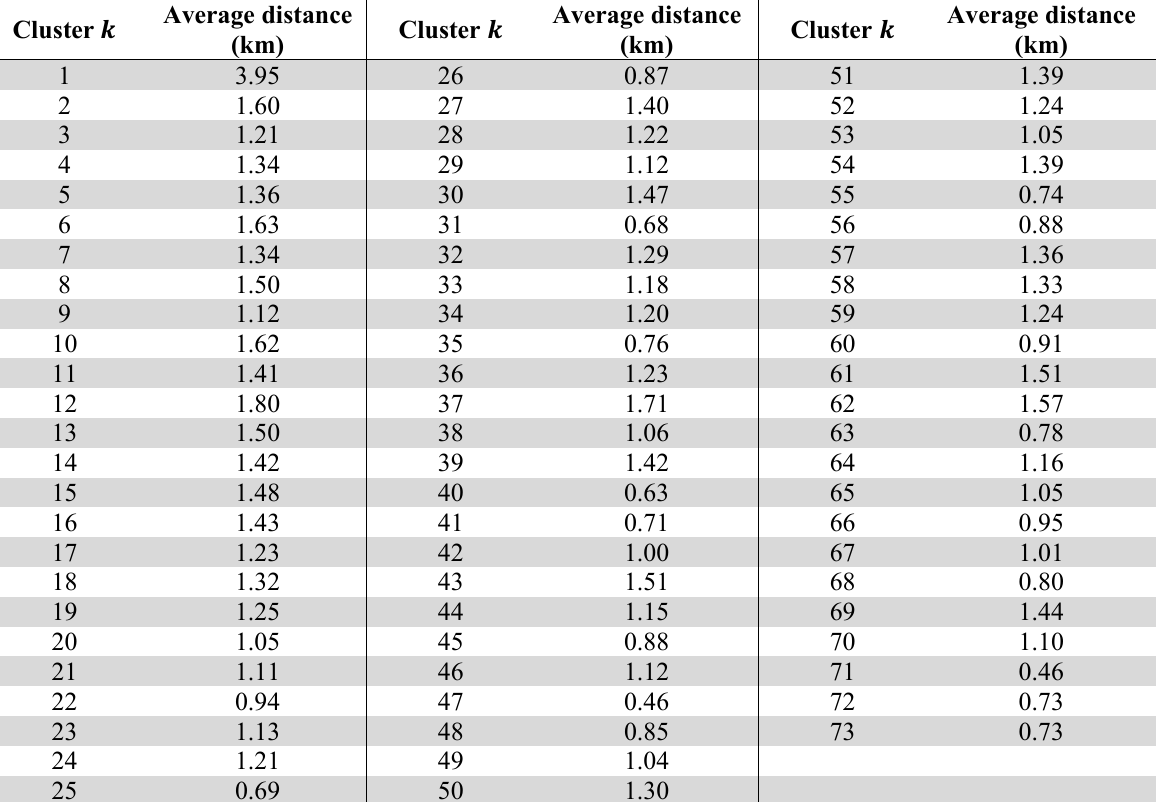
Fig. 6. Example of geographical distribution of ten clusters generated with a) centroid-based algorithm, and b) sweep algorithm Results of centroid-based algorithm for Day